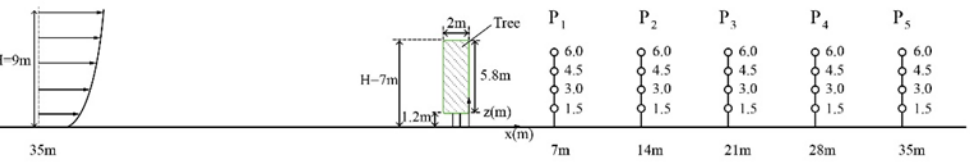
Figure 2. Configuration of canopy and measurement positions in the field measurement.